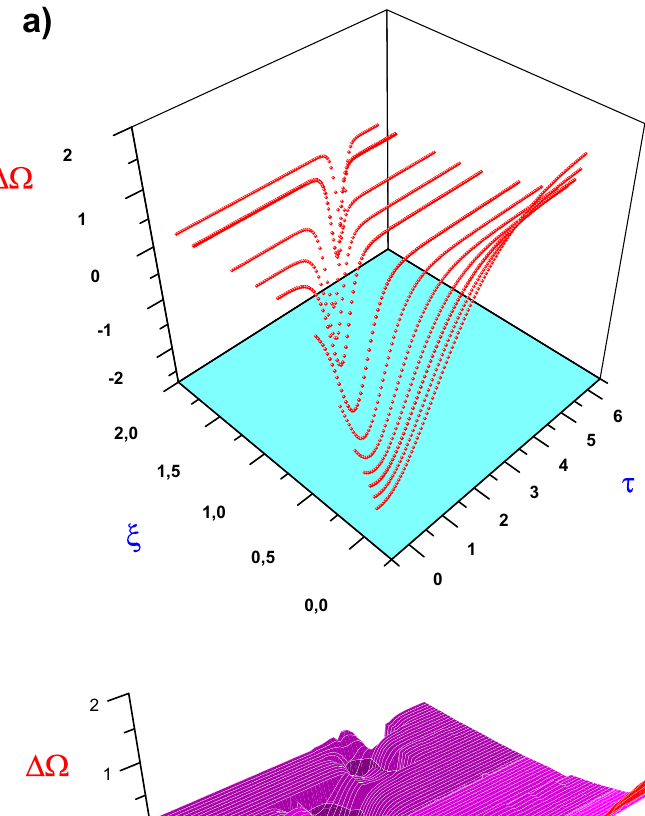
An Acad Bras Cienc (2022) 94(2) e20210678 16 |